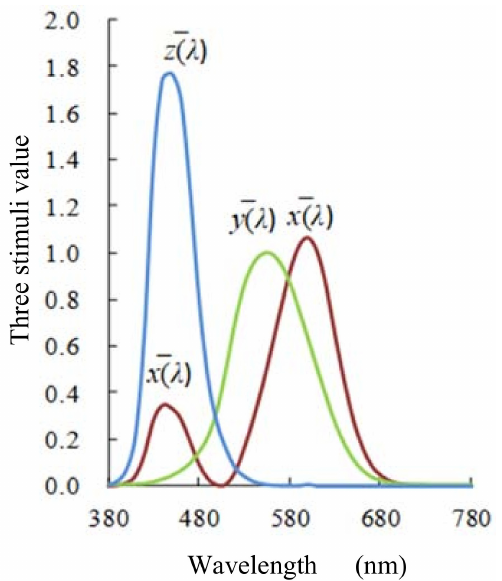
Figure 2. 1931CIE-XYZ standard x ( λ ), y ( λ ) and z ( λ ). The three curves represent the radiation value of chromatic tricolor in the D50 [23] light source with the wavelength of visible light. The three